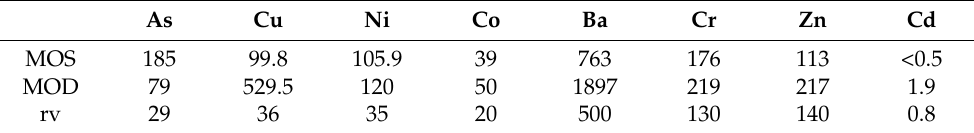
Table 1. Concentrations of risk elements’ metals in technogenic substrates MOS and MOD; rv, reference value ( µ g.g − 1 ) represents the maximum permissible concentration of a hazardous substance in the soil set by Act No. 220/2004 Protection and Utilization of Agricultural Soil by Ministry of Agriculture, Environment and Regional Development of the Slovak